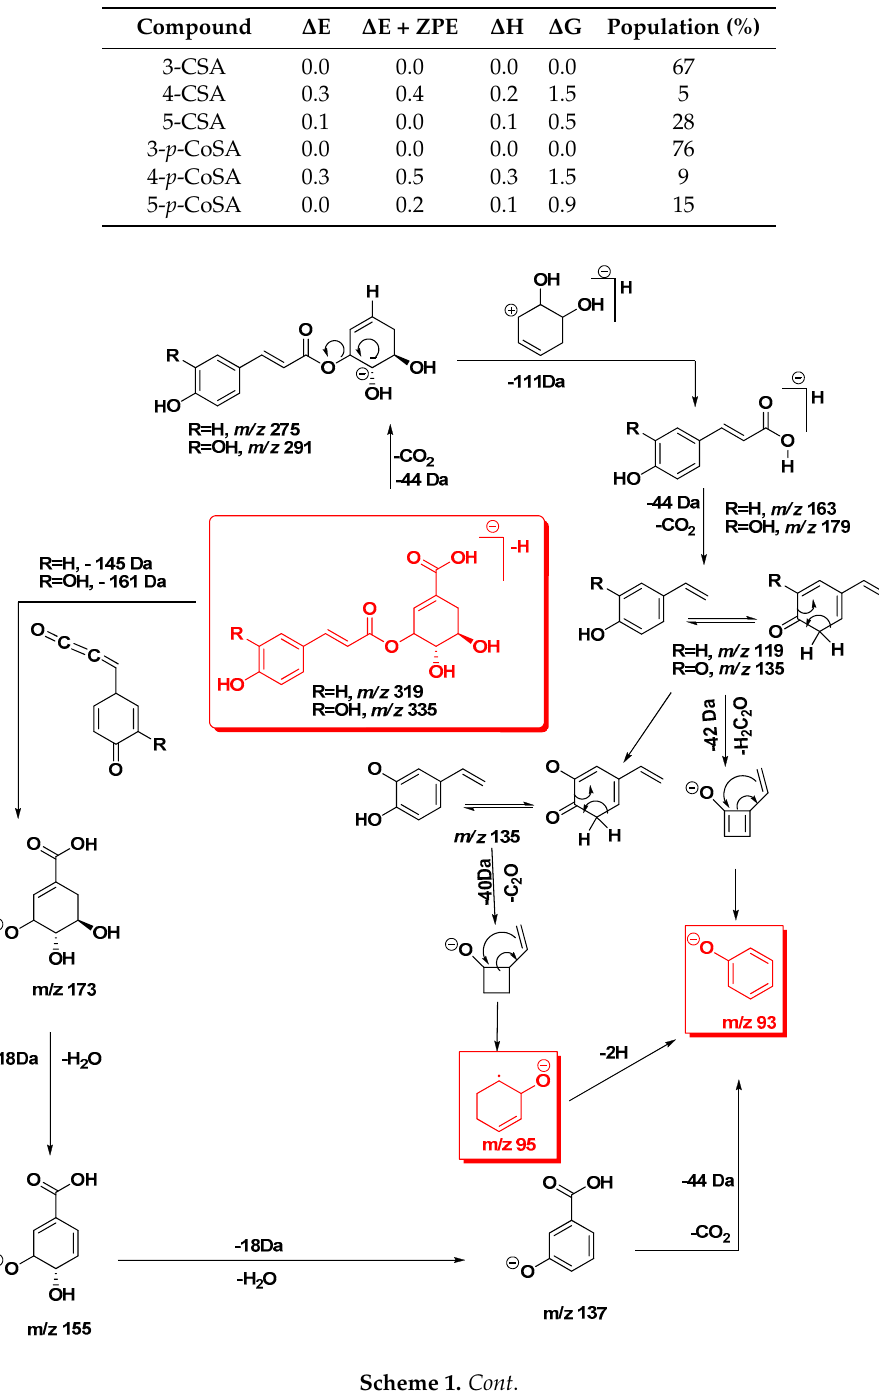
Table 2. Relative energies (kcal · mol − 1 ) and populations at 298 K in the gas phase of caffeoylshikimic acid (CSA) and p -coumaroylshikimic acid (3- p -CoSA)isomer’s calculated at the B3LYP/6-31 + G(d,p) level. Compound